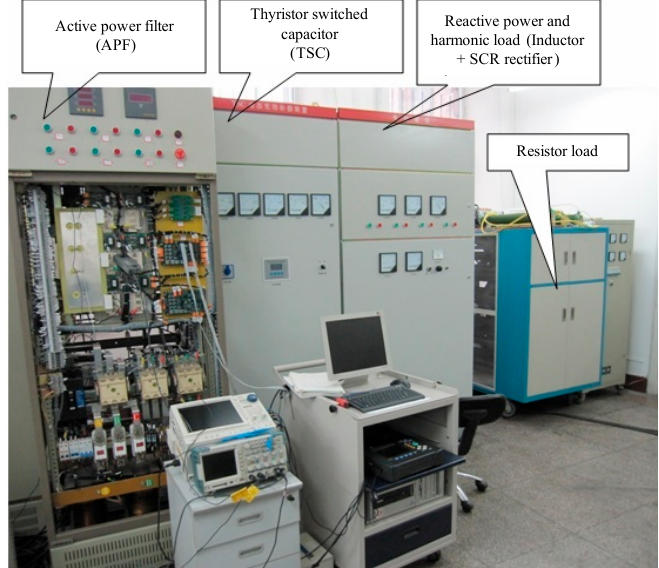
Figure 16. Photo of laboratory prototype.